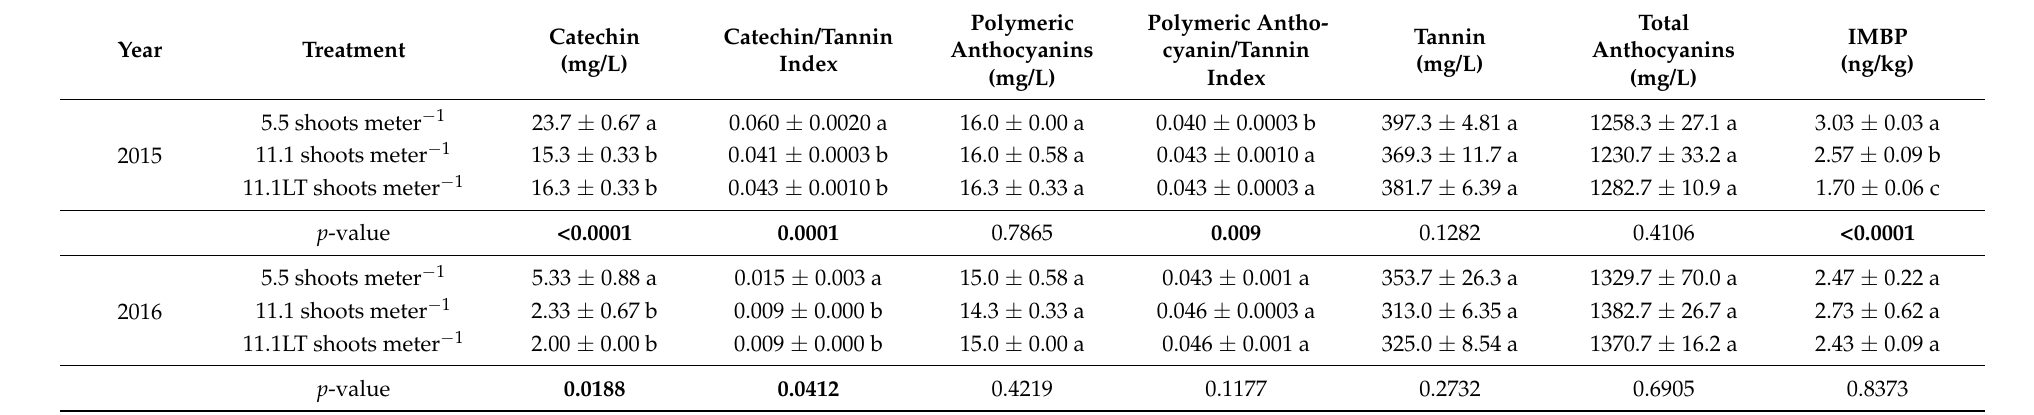
Table 11. One-way analysis of variance (ANOVA) showing Catechin, Catechin/Tannin Index, Polymeric Anthocyanins, Polymeric Anthocyanin/Tannin Index, Tannins, Total Anthocyanins, and IMBP (ng/kg) by year and treatment at harvest during the 2015 and 2016 growing seasons ( n = 3). Table shows treatment means followed by the standard error of the mean. Different letters within a column indicate significant differences based on an Each pair, Student’s t -test. Significant p -values (<0.05) are displayed in